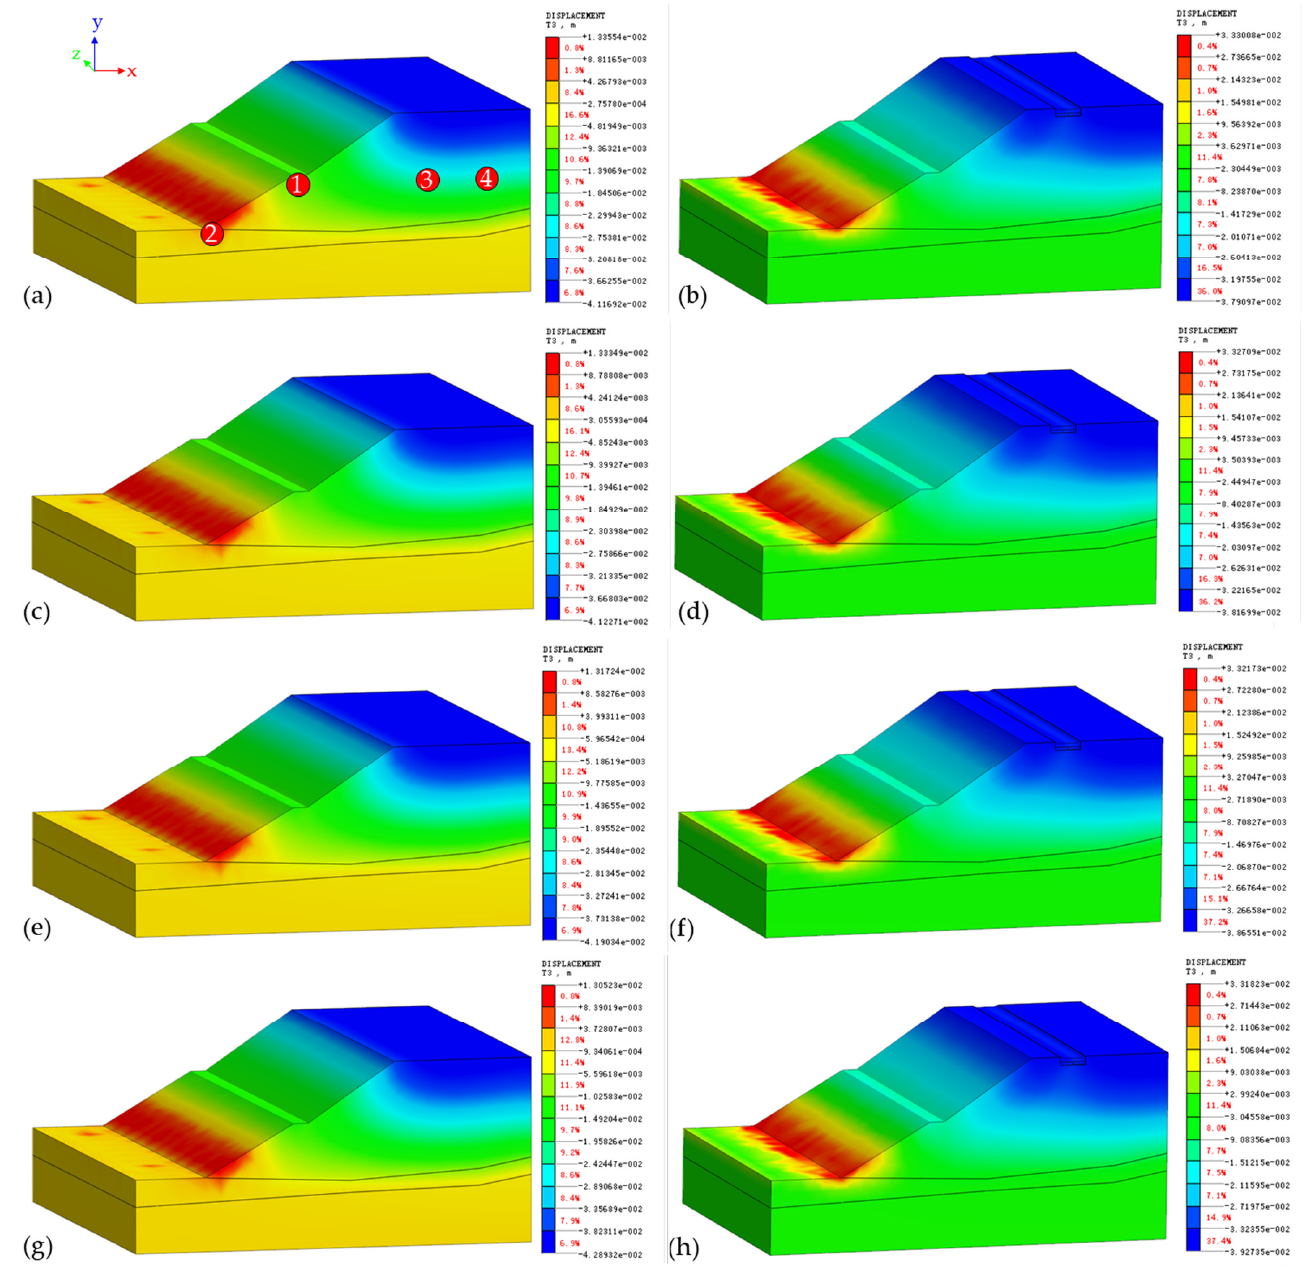
Figure 10. Comparison of vertical displacement distribution in subgrade slopes without or with biological retention facilities within 48 h after rainfall: ( a , b ) 6 h; ( c , d ) 12 h; ( e , f ) 24 h; ( g , h ) 48 h.